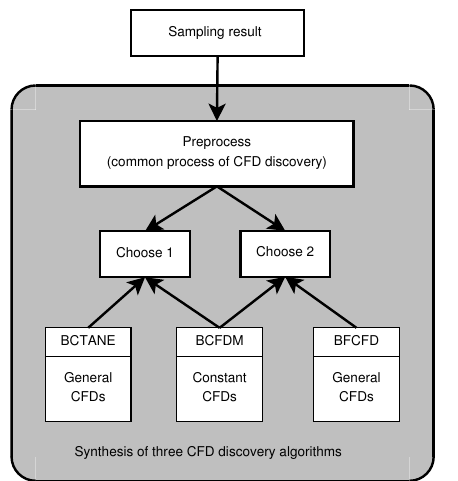
Fig. 2 Overview of DFCFD